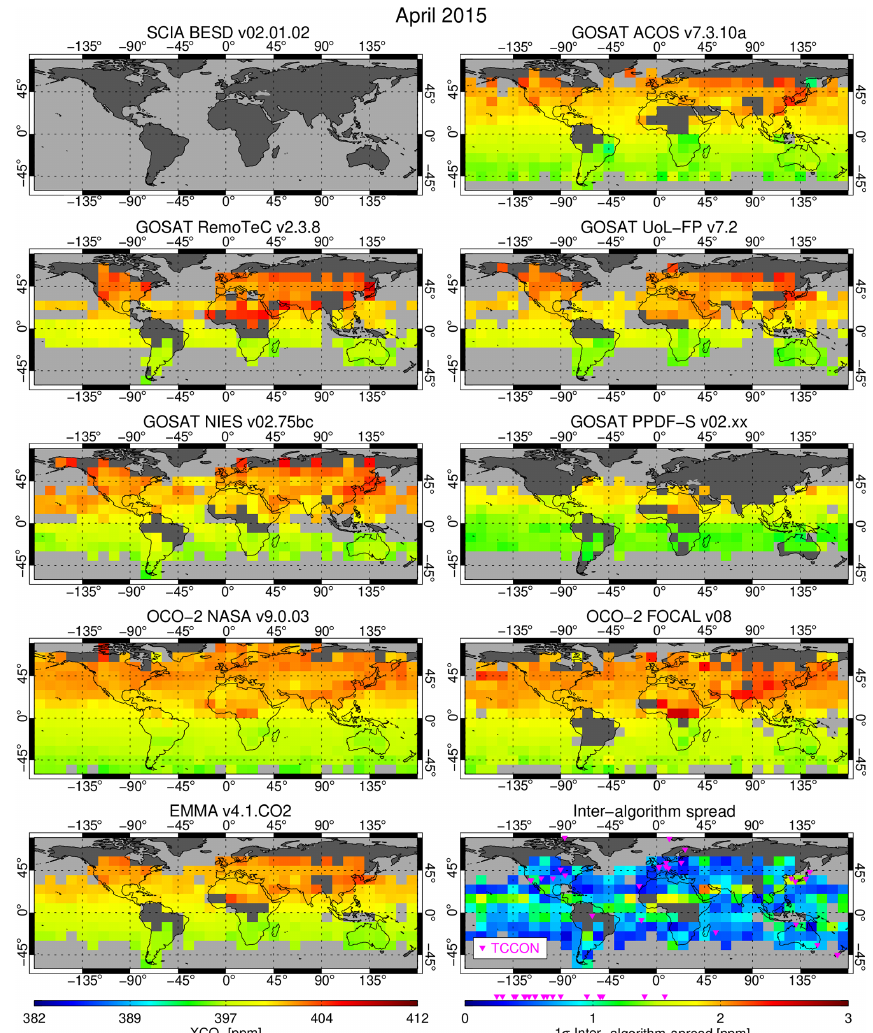
Figure 10. As Fig. 9 but for April 2015. Note that the SCIAMACHY/BESD map (top left) is empty because this product ended in April 2012 (see Fig. 9 for SCIAMACHY/BESD XCO 2